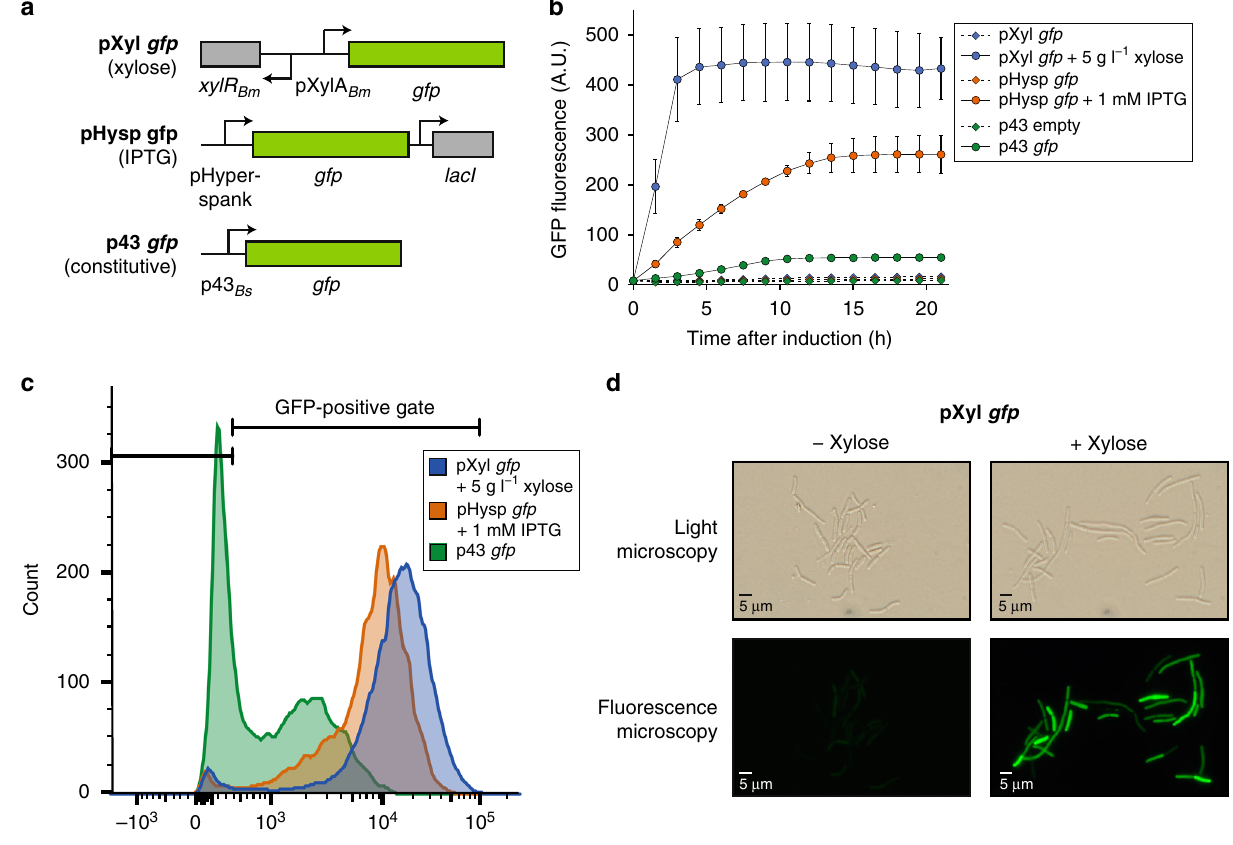
Fig. 2 Heterologous protein expression and promoter evaluation in SR7. a Schematic of the promoters tested in SR7. pXyl is a xylose-inducible promoter and contains the xylR gene and xylA promoter from B. megaterium strain DSM 319. pHysp contains the IPTG-inducible hyperspank promoter and lacI , both from plasmid pDR111. The p43 promoter is taken from B. subtilis strain KS438 and is growth-associated. Expected inducers are indicated in parentheses. b Bulk fl uorescence measurements of SR7 populations containing gfp- encoding plasmids, with (circles, solid lines) or without (diamonds, dashed lines) inducers. Error bars represent the standard deviation of biological triplicate samples. c Fluorescence populations of SR7 cells expressing gfp at 4 h post induction measured by FACS (Alexa Fluor 488). A GFP positive gate was established using the auto fl uorescence of SR7 cells containing an empty plasmid control. d Phase-contrast and fl uorescence microscopy of SR7 pXyl gfp cells with and without xylose induction. Images were taken 4 h post induction. Source data are provided as a Source Data fi le